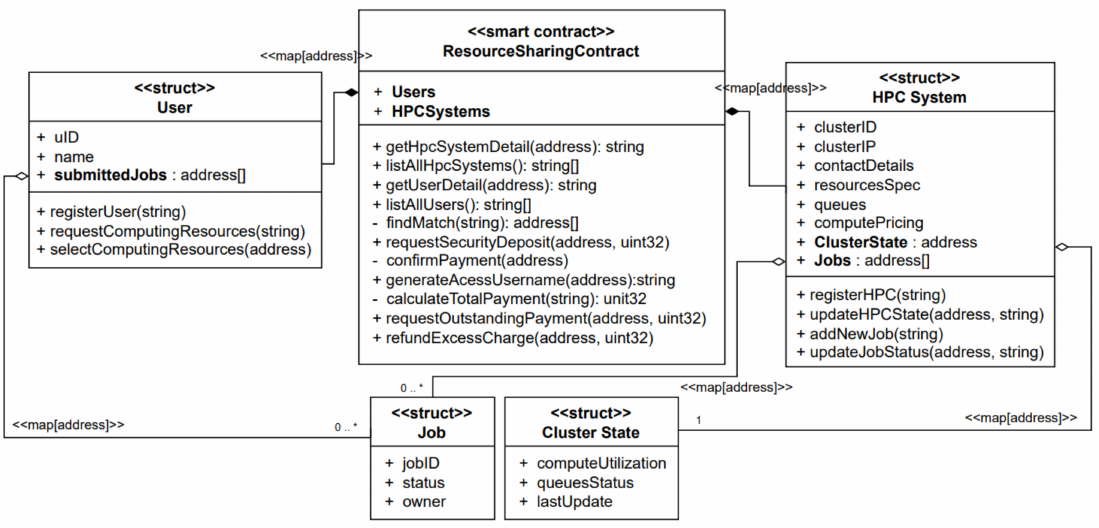
Figure 3. Class Diagram of Resource Sharing Smart Contract.